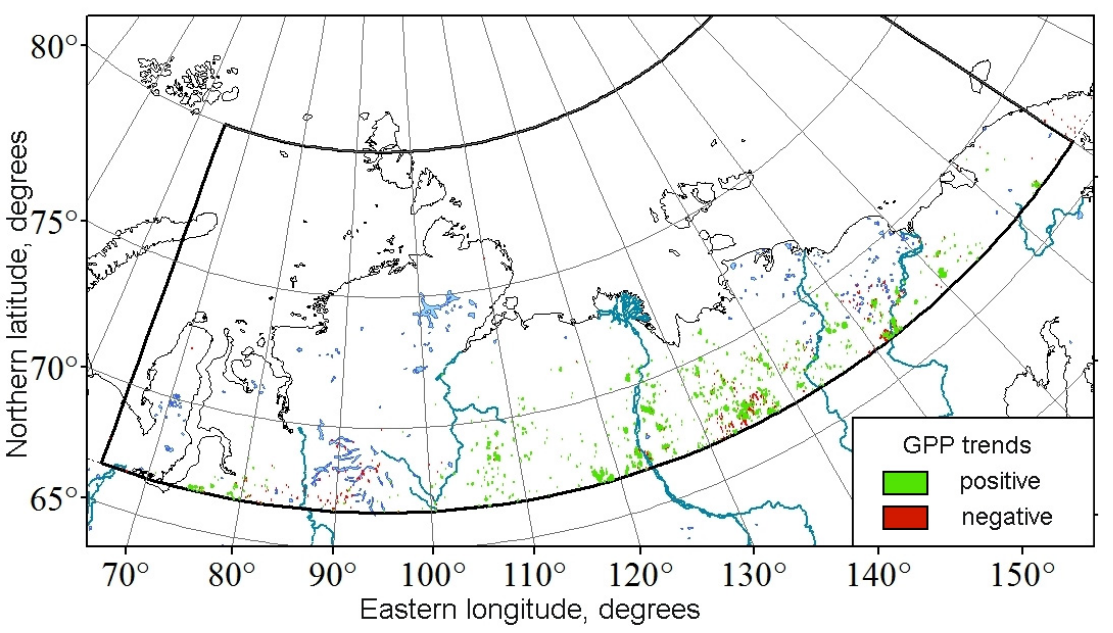
Figure 5. Gross primary productivity (GPP) post-fire trends within “hot spots”. GPP increasing and decreasing trends observed within 97.3% and 2.7% of “hotspots”, correspondingly. Trends significant at p < 0.05. Note: hot spots presented as a non-scale points.